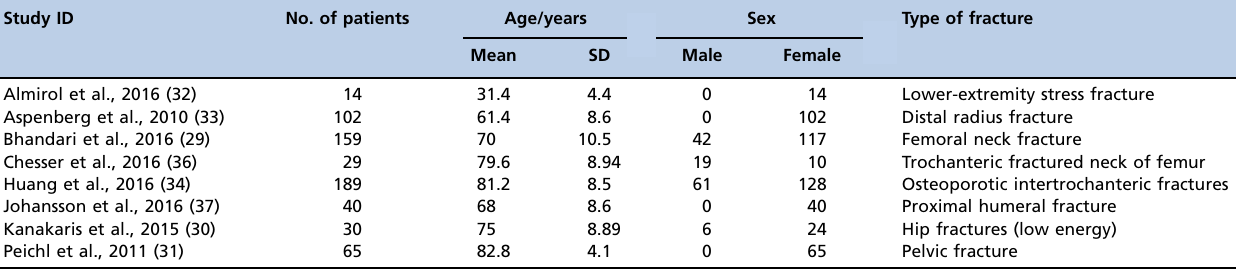
Table 1 - Characteristics of the included studies.